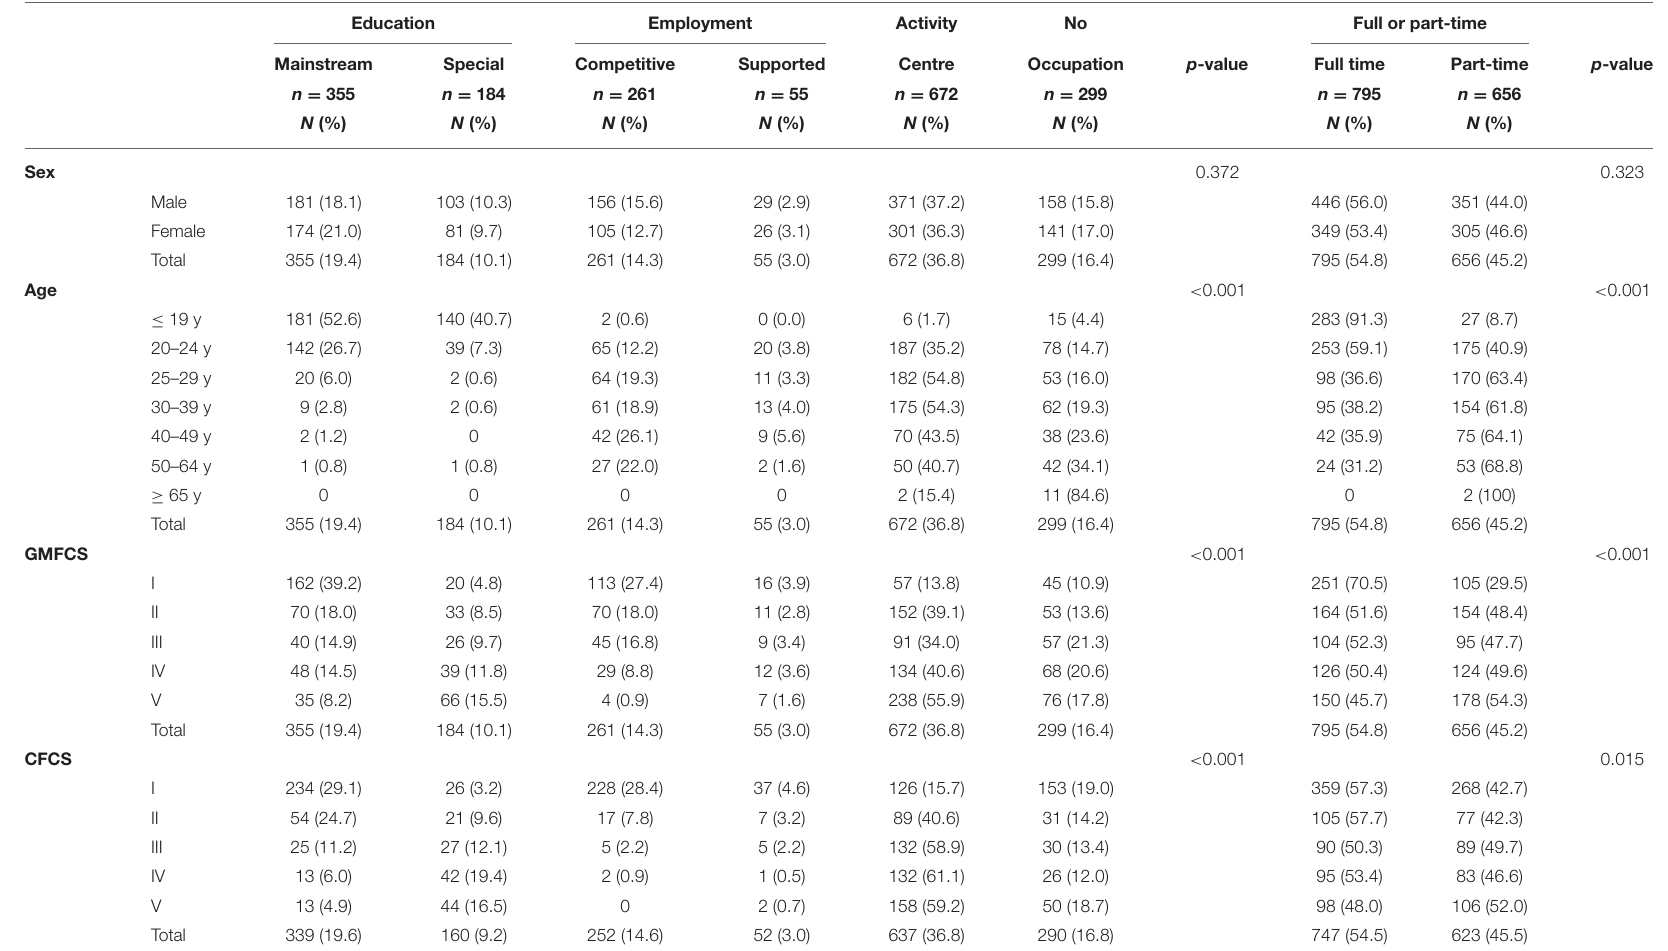
TABLE 6 | Primary occupation and full-time or part-time occupation for all adults with CP relative to their sex, age, GMFCS, and CFCS